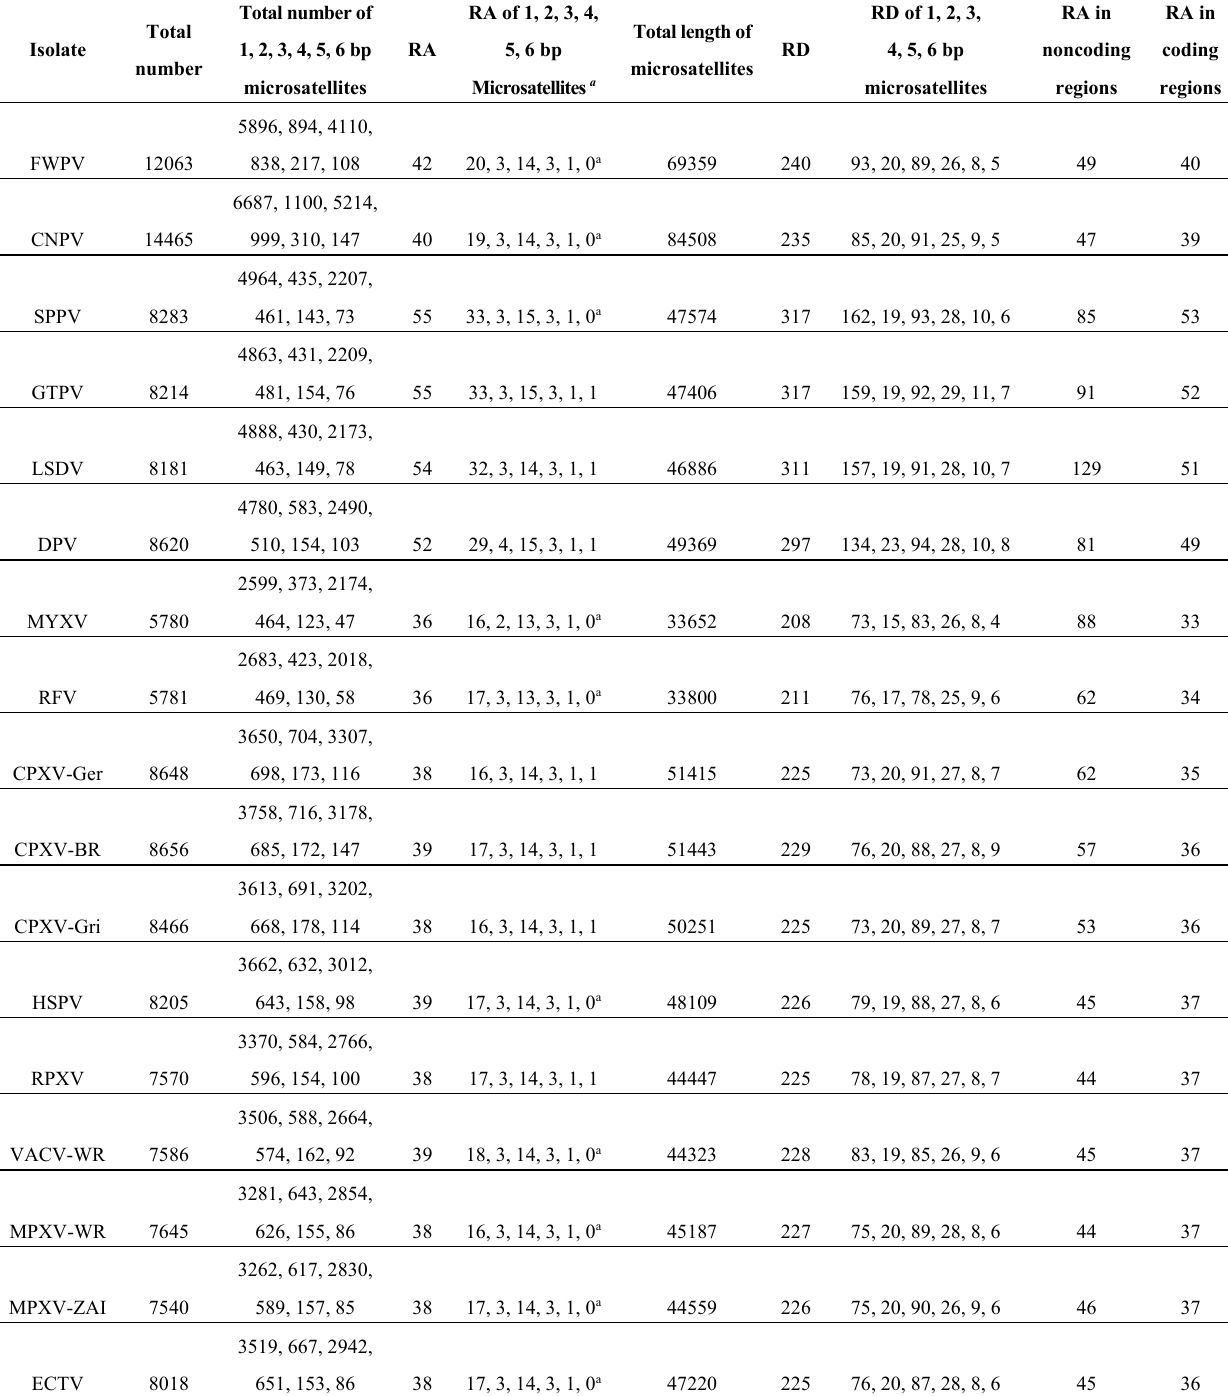
Table 3. Description of the microsatellite sequences identified in Poxviridae genomes. Comparative abundance of repeats is shown. The high GC viruses are shown at the bottom of the